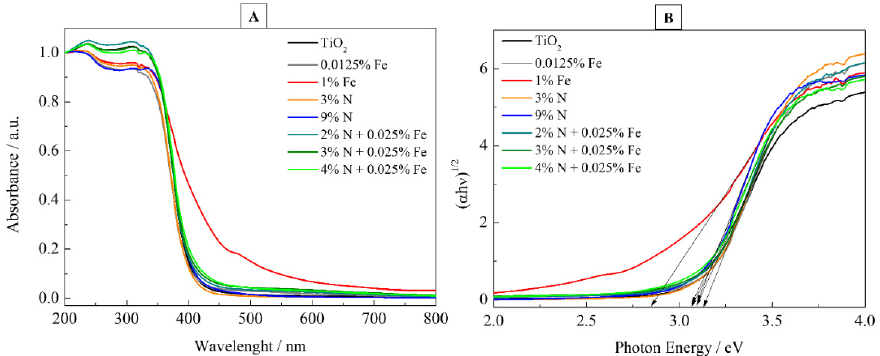
Figure 8. ( A ) UV-Vis absorbance spectra for the synthesized photocatalysts. ( B ) Tauc plots of pho- tocatalysts with different % N and Fe. Table 3. Band gap energy values for all